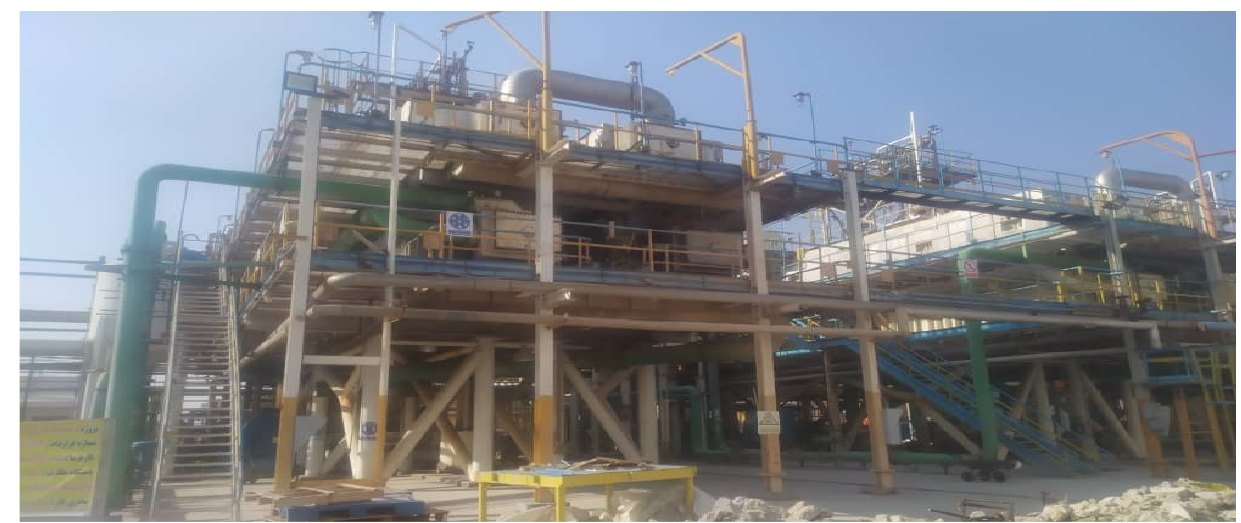
Figure 3. MSF-BR desalination system of the Abadan refinery complex .